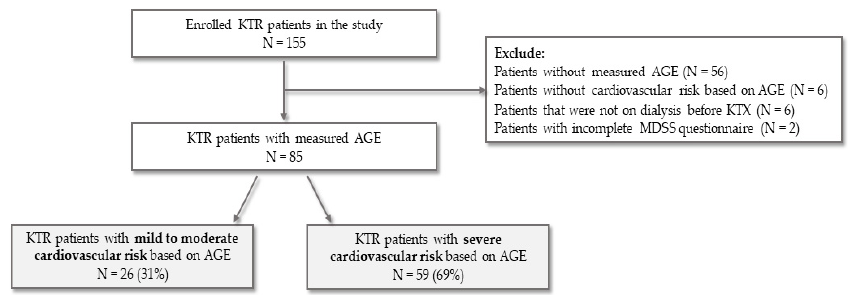
Figure 1. Flowchart of the study protocol. Table 1. General characteristics of study participants and differences according to cardiovascular risk